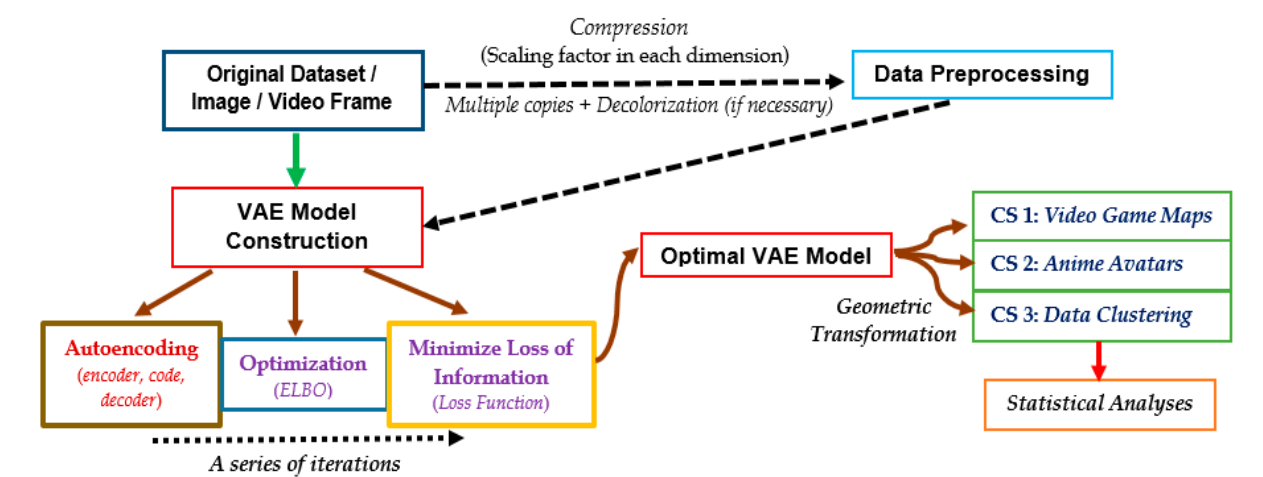
Figure 1. Overall flowchart of this study, from extraction of the original dataset, model construction, and optimization to statistical analyses. CS: Case Study.